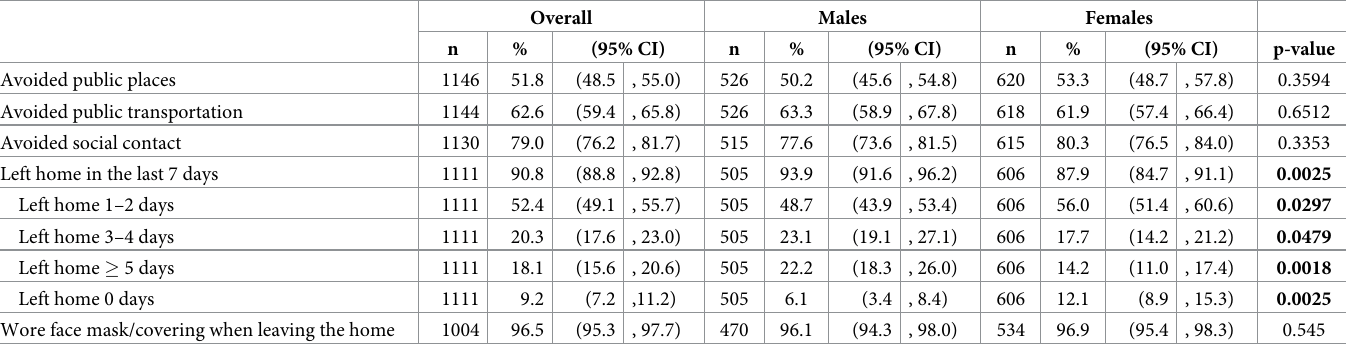
Table 5. Ecuador COVID-19: Survey findings on practices.